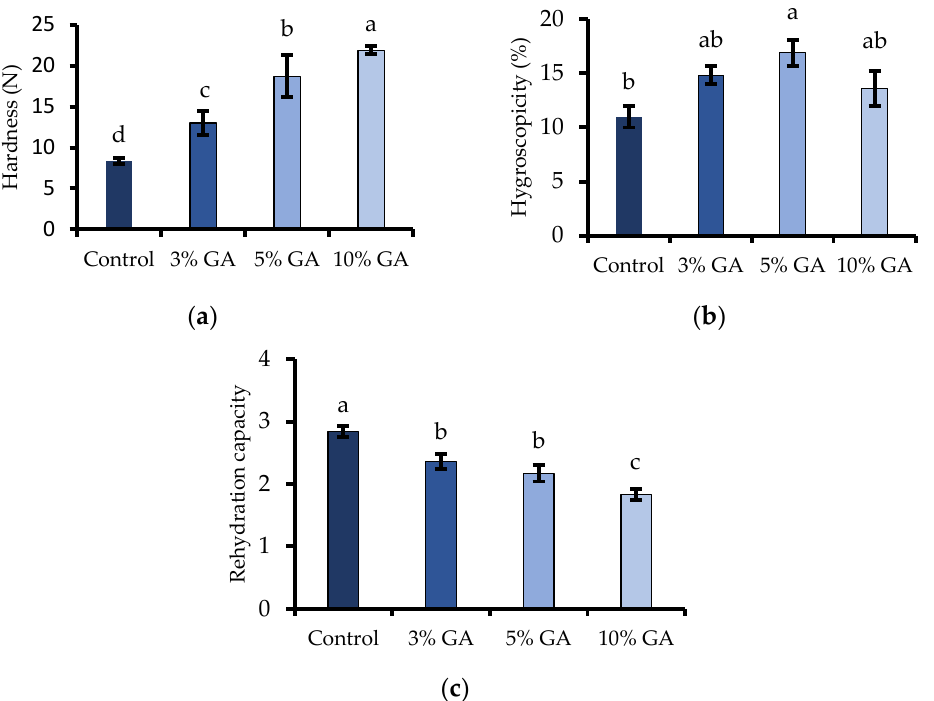
Figure 1. ( a ) Hardness, ( b ) hygroscopicity, and ( c ) rehydration capacity of the control, GA-pretreated and oven-dried (60 °C for 18 – 24 h) raspberries. Different letters on each bar indicate significant differences in the means ( p < 0.05) according to Duncan’s multiple range test. Vertical bars indicate the standard error of the mean. Control samples were dipped in distilled water for 2 min.